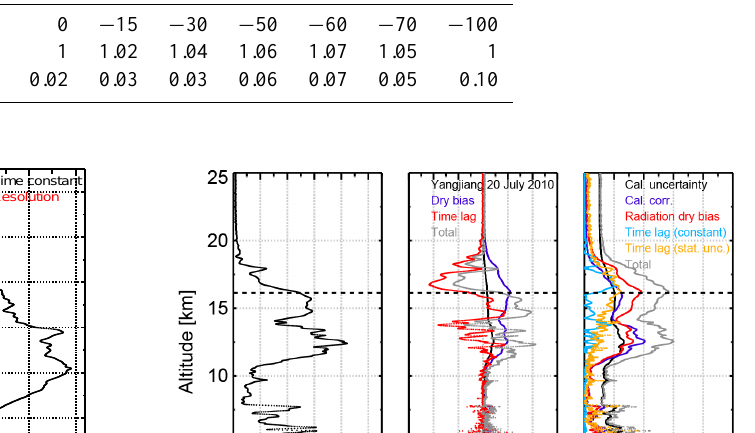
Table 3. Parameters for the temperature-dependent calibration correction of humidity values. The first row lists the correction factor, and the second row the uncertainty of the correction.